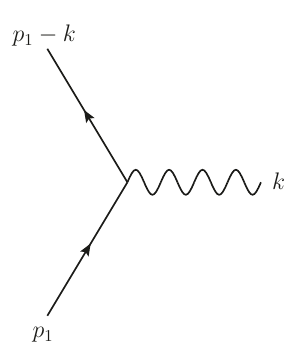
Figure 3. The three point interaction involving the massive gauge